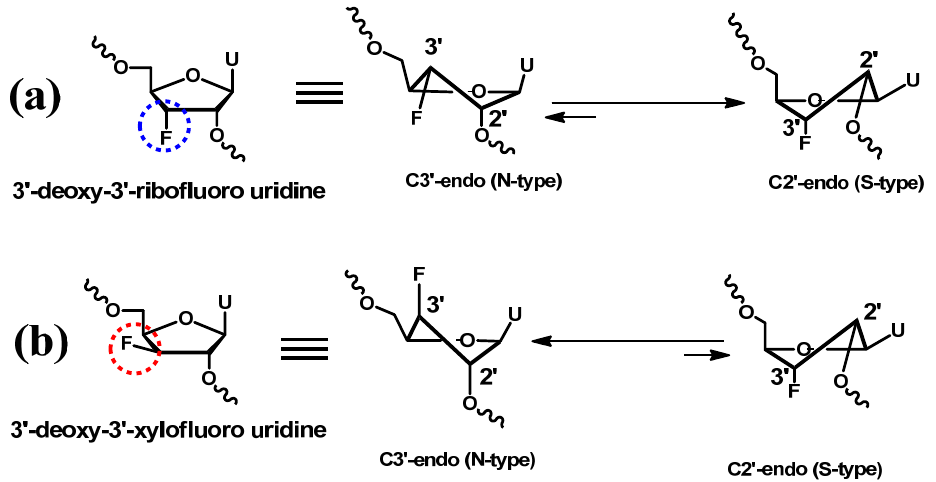
Figure 7. Structure and sugar puckering equilibrium for ( a ) 3’-deoxy-3’-ribofluorouridine. ( b ) 3’-deoxy-3’-xylofluorouridine.S-type (C2’-endo) conformation (preferred by 3’-deoxy- 3’-ribofluorouridine) stabilized iso DNA:RNA duplexed while N-type (C3’-endo) conformation (preferred by 3’-deoxy-3’-xylofluorouridine) destabilized iso DNA:RNA duplexes.